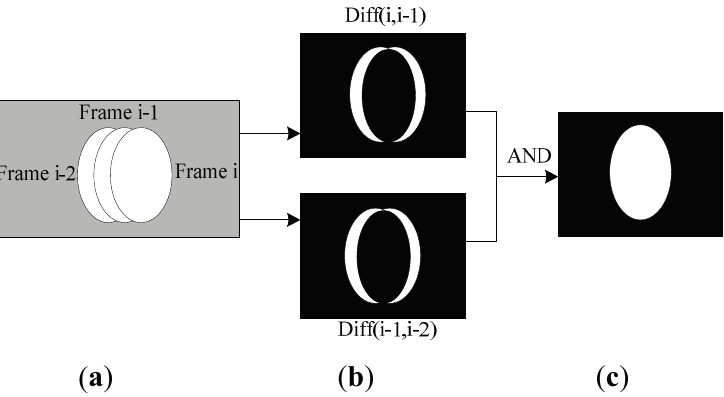
Figure 5. Binary motion region extraction. ( a ) motion region in three sequent frames; ( b ) binary difference image; ( c ) Binary motion region extraction